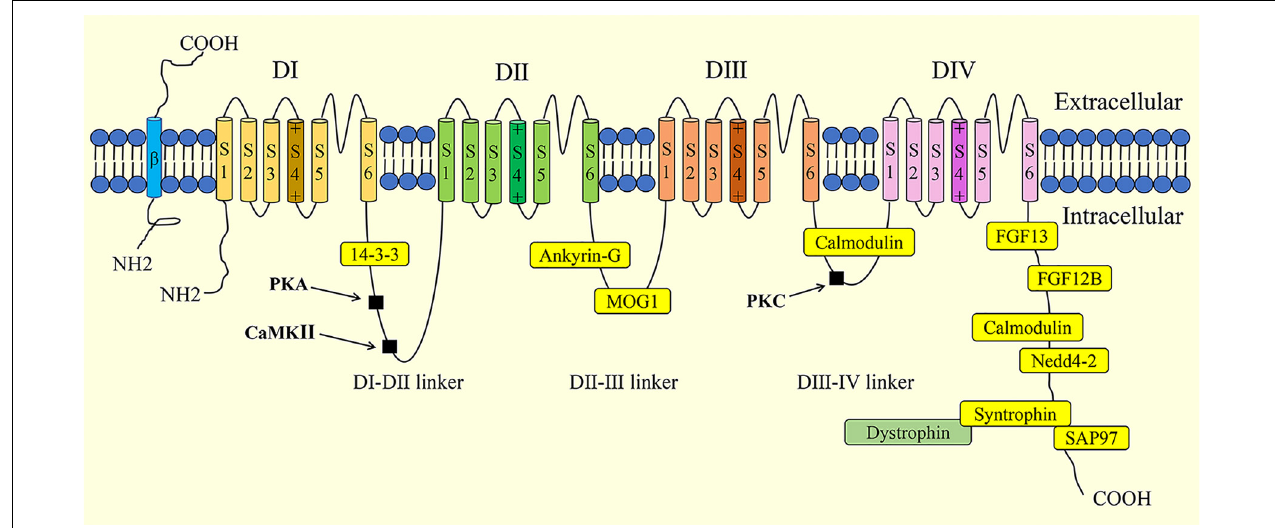
FIGURE 1 | Schematic illustration of the structure of cardiac sodium channel (Na V ,1.5) and its interaction proteins. Phosphorylation sites are indicated in black squares. PKA, protein kinase A; CaMKII, Ca 2 + /Calmodulin-dependent kinase II; PKC, protein kinase C; FGF, fibroblast growth factor; SAP97, synapse-associated protein